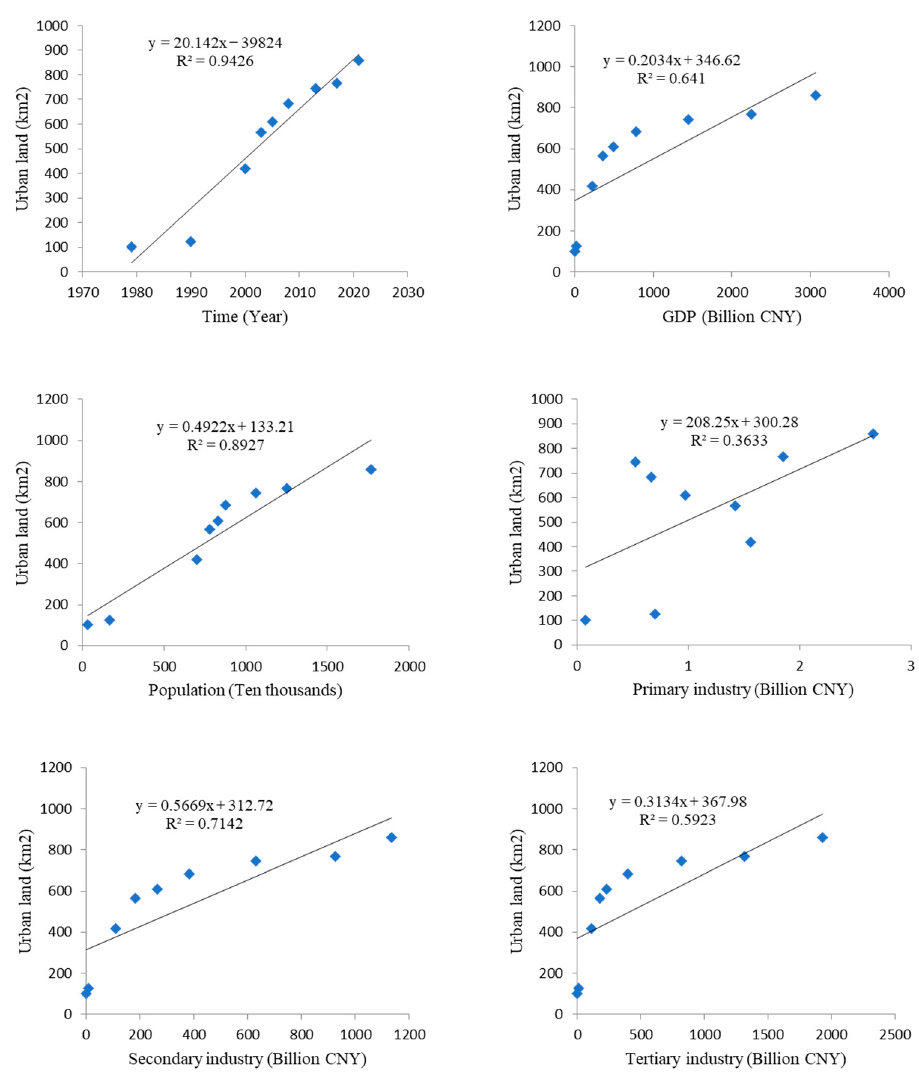
histograms for urban land increase.